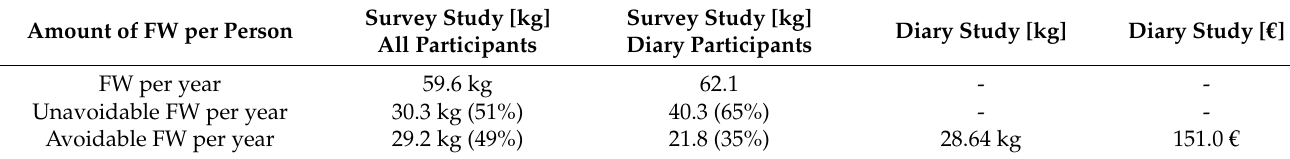
Table 8. Food waste estimates by survey and dairy